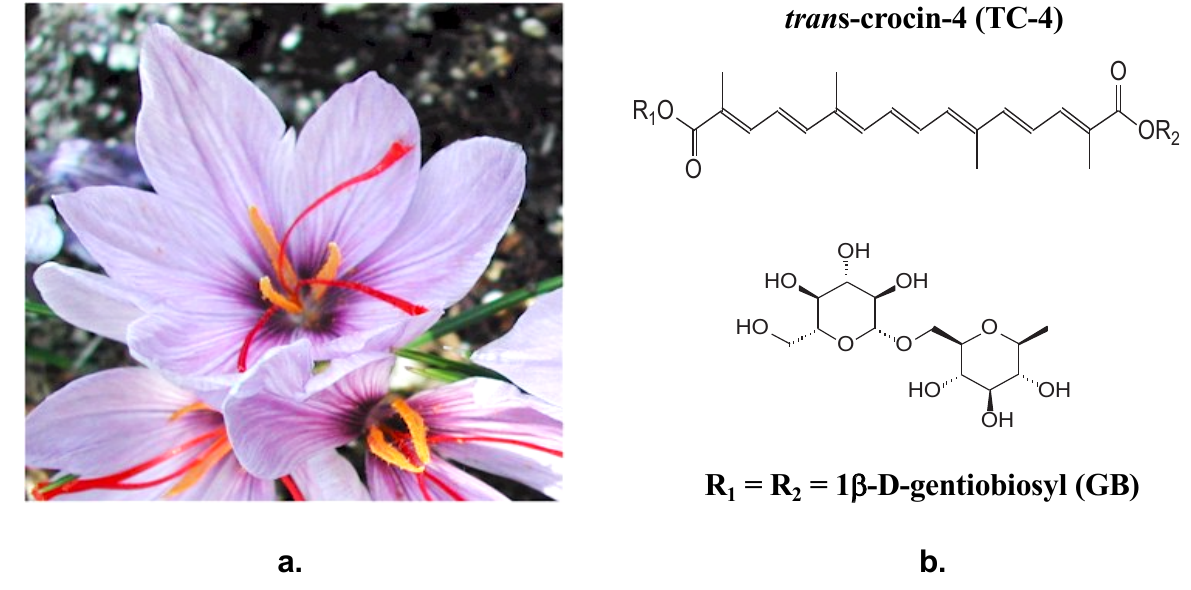
Figure 2. Chemical structure of the bioactive component trans-crocin-4 (TC-4) isolated from the stigmas of Crocus sativus L. (a). TC-4 (b) is one of the major crocins of saffron and is chemically a crocetin molecule esterified with two 1β-D-gentiobiosyl units GB (R1 and R2 =